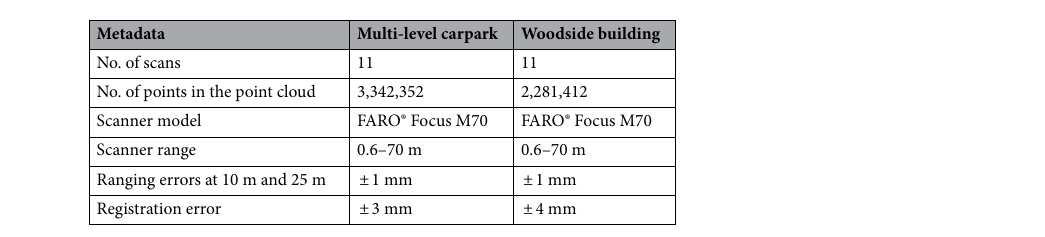
Table 4. Metadata of the case study buildings point cloud